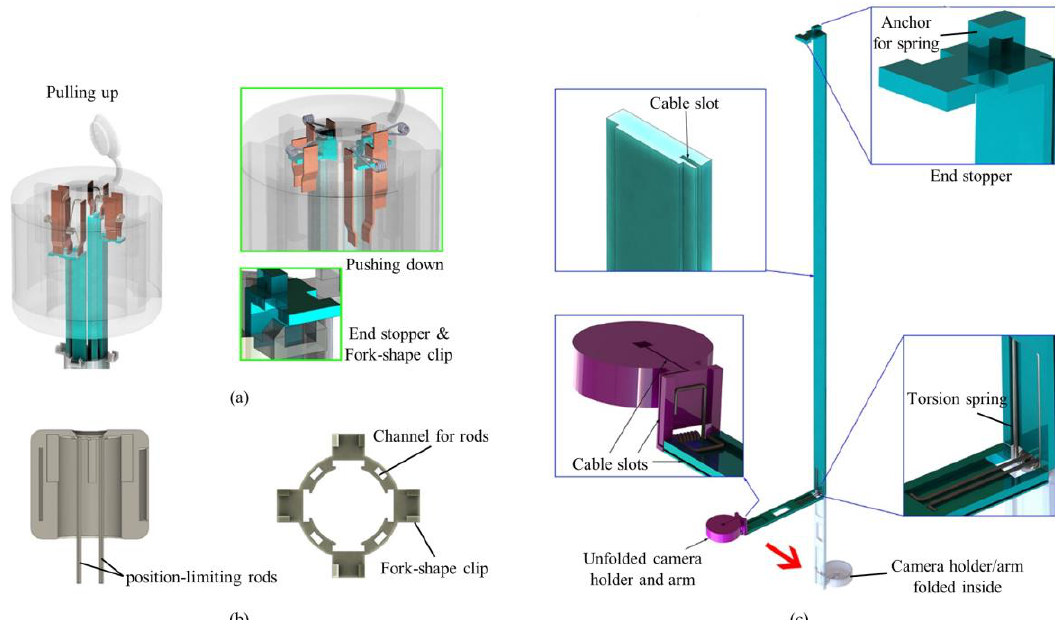
Figure 2. Mechanical system of a TCA. ( a ) The working mechanism of the push button. Pliant plates and torsion springs push down aluminum arms and deploy multiple cameras sequentially. The four fork-shape clips and the end stopper of the arms are utilized to stop and hold the arms. The fork on the clip can separate the pliant plate pairs to bypass the stopper of the arms. ( b ) Cross-section of the push button and top view of the surgical port. ( c ) A foldable camera support consists of two aluminum arms, torsion springs, and a camera holder.